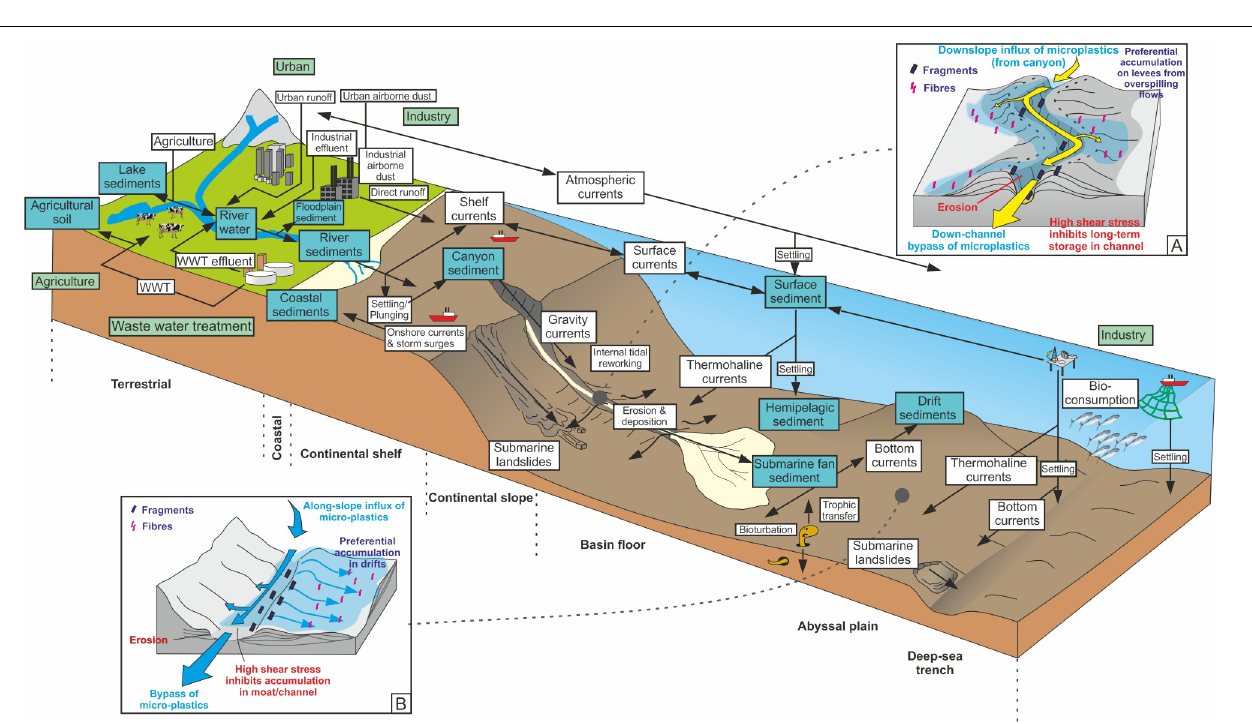
FIGURE 3 | Microplastic input, transport vectors, and sinks. Green boxes represent primary input, blue boxes range boxes represent temporary and permanent sinks, white boxes represent transport mechanisms and arrows represent transport vectors. Insets show the potential distribution and transport vectors of microplastics in (A) a channel-levee system and (B) a bottom current moat and drift system, respectively. Modified and extended (to include marine realm) from Horton and Dixon (2017). WWT, waste water treatment.